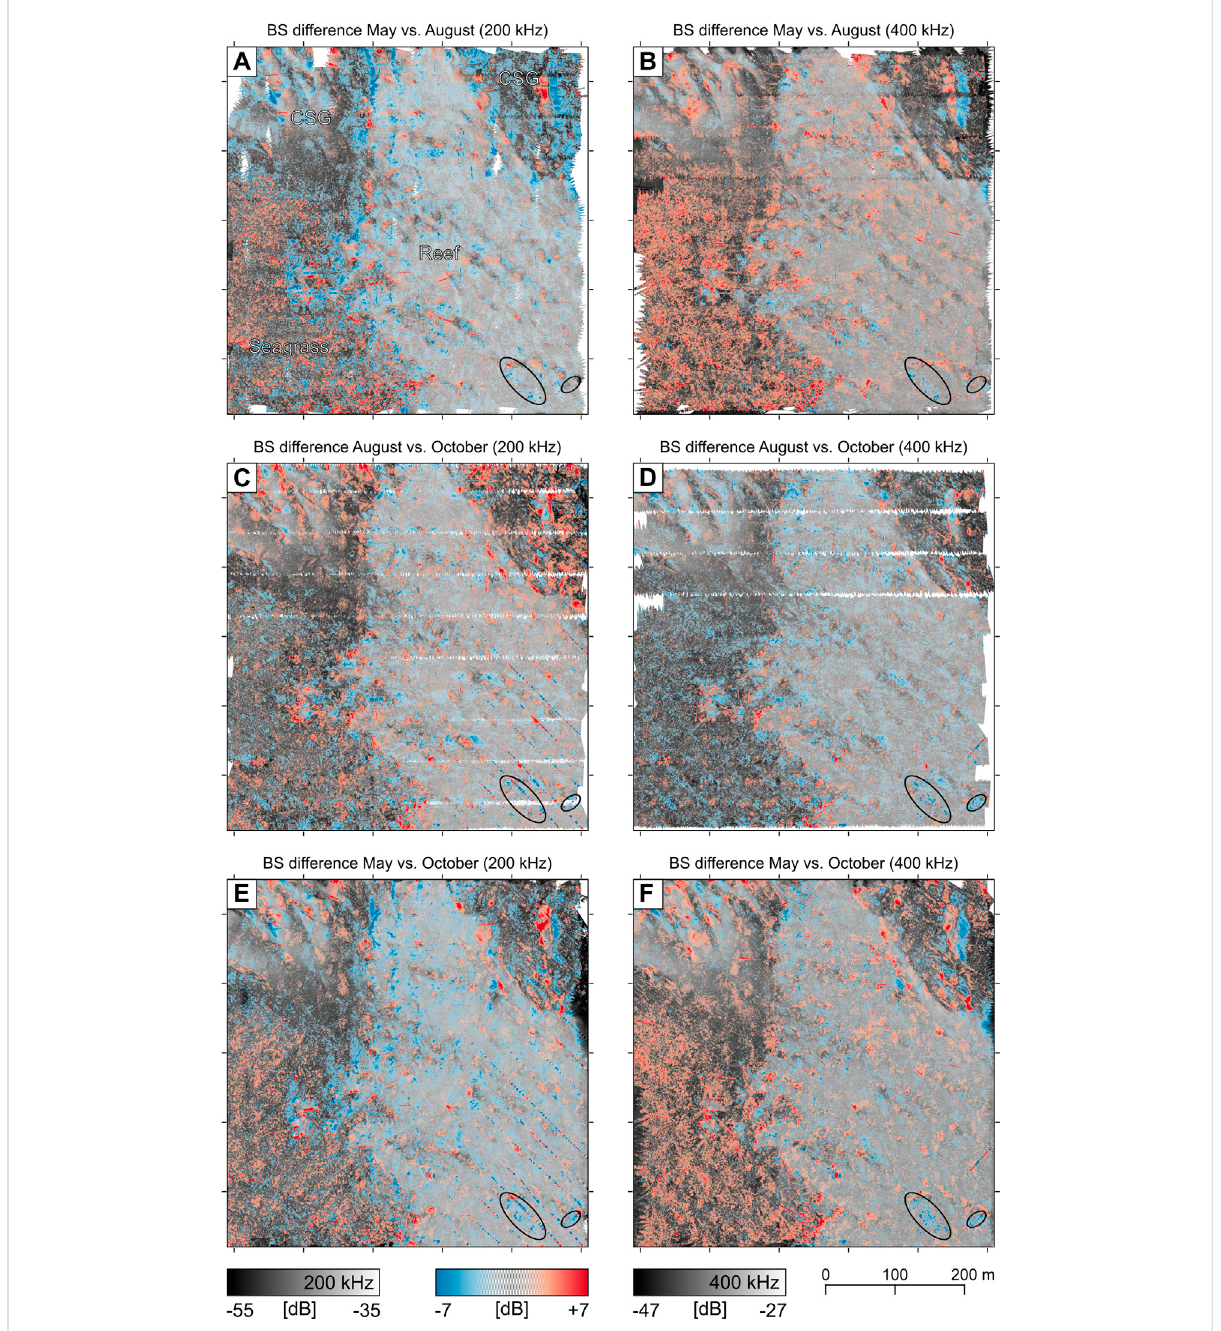
FIGURE 5 Difference plotsofacousticbackscatterbetweenMay,August,andOctober,witha5celllowpass fi lter.Redcolorcorrespondstoanincreasein the backscatter strength; blue color corresponds to a decrease in the backscatter strength. The center of the color map is transparent to highlight only relevant differences. The backscatter map in the background was recorded in May (A,B) , August (C,D), and October (E,F) . The circles mark seagrass patches enclosed by the reef and show a reversed seasonal backscatter